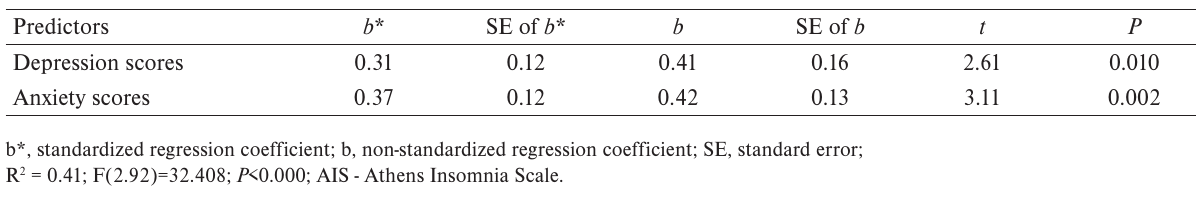
Table 2. Predictors of the total AIS score, the results of stepwise progressive regression.